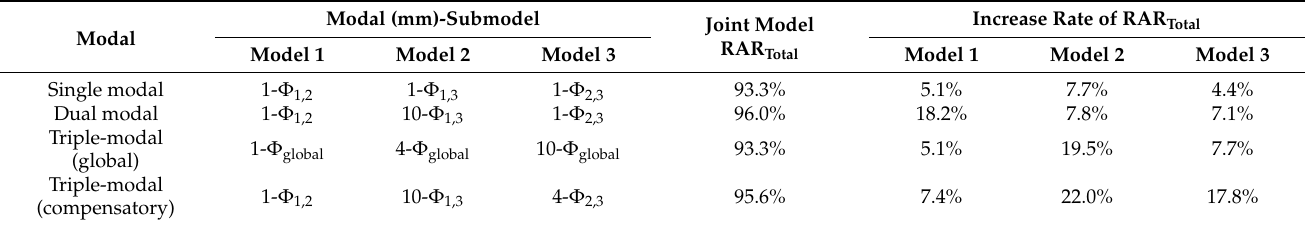
Table 8. Comparison of the modeling discrimination effects for the optimal joint models of the three-model voting fusion and their sub-models.